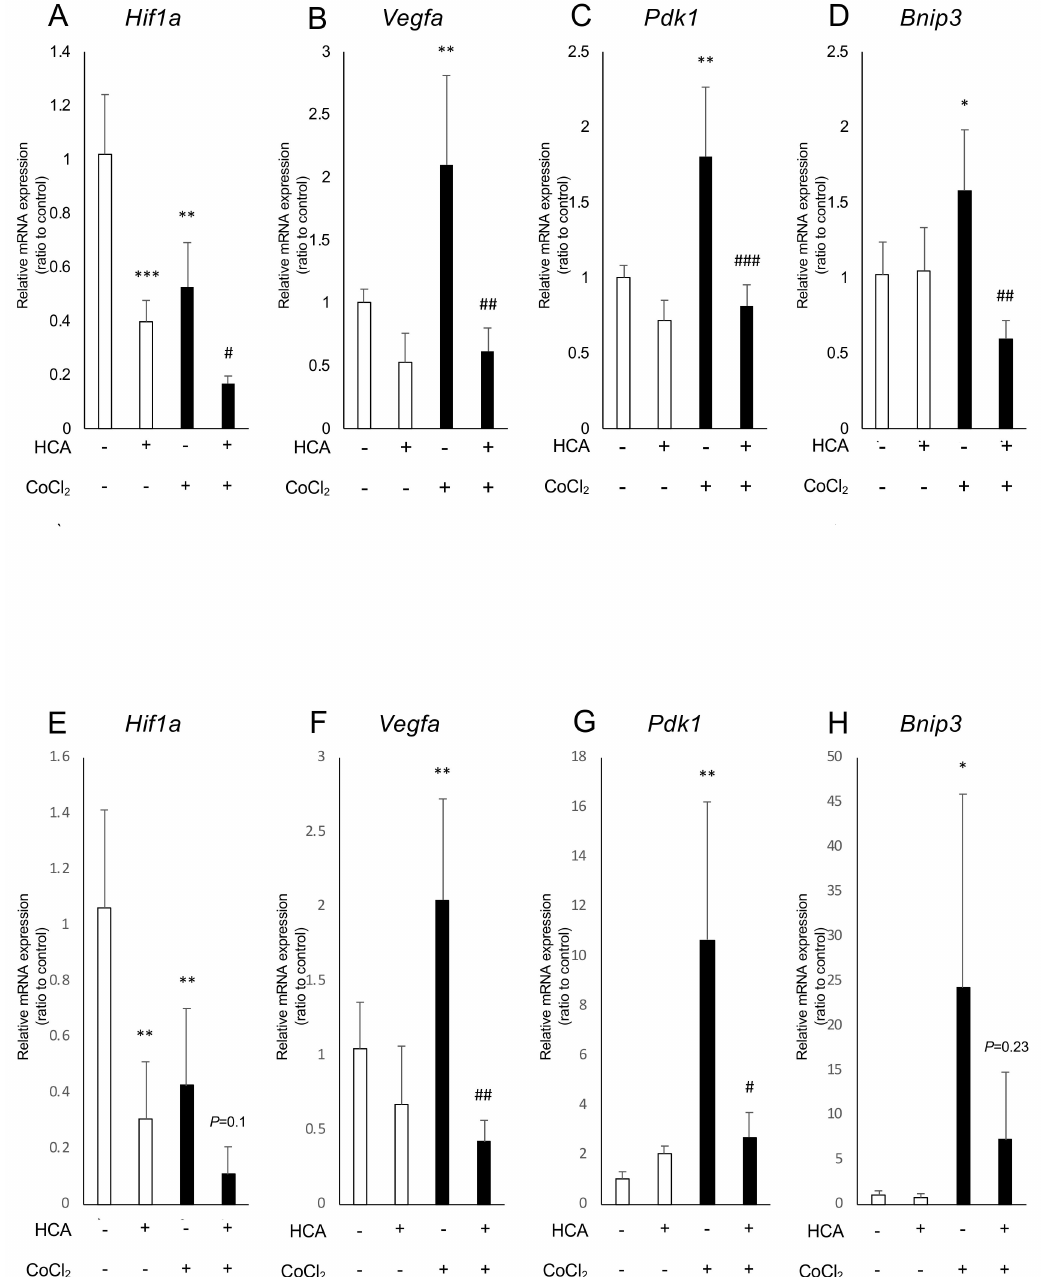
Figure 3. Hif1a and the downstream genes were downregulated by HCA administration. ( A ) Hif1a was downregulated by HCA administration with or without CoCl 2 in ARPE19 cells. The downstream genes of HIFs including ( B ) Vegfa , ( C ) Pdk1 , and ( D ) Bnip3 were significantly downregulated by administration of HCA in ARPE19 cells. Hif1a was downregulated by HCA administration in 661W cells significantly without CoCl 2 . ( F ) Vegfa and ( G ) Pdk1 were significantly downregulated by administration of HCA in 661W cells. ( H ) Bnip3 also showed a similar tendency. * P < 0.05, ** p < 0.01, *** p < 0.001 compared with the control. # p < 0.05, ## p < 0.01, ### p < 0.001 compared with CoCl 2 without chetomin and HCA, n =